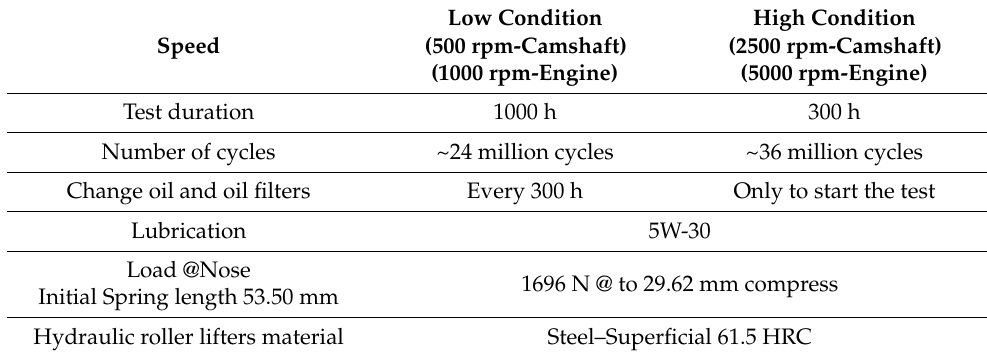
Table 1. Camshaft bench testing